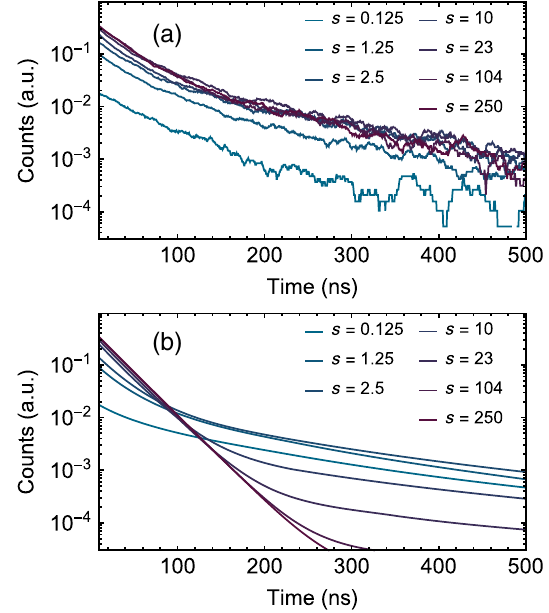
FIG. 10. (a) Photon-count decays acquired for different ex- citation intensities. (b) Numerical simulations performed with a nonlinear coupled-dipole model, using 100 atoms at a density 3 ¼ 0 . 3 . The traces have been normalized to the steady-state ρ 0 =k value of the measurement at largest intensity. Here, we define the origin of the time ( t ¼ 0 ) 30 ns after switching off the excitation.